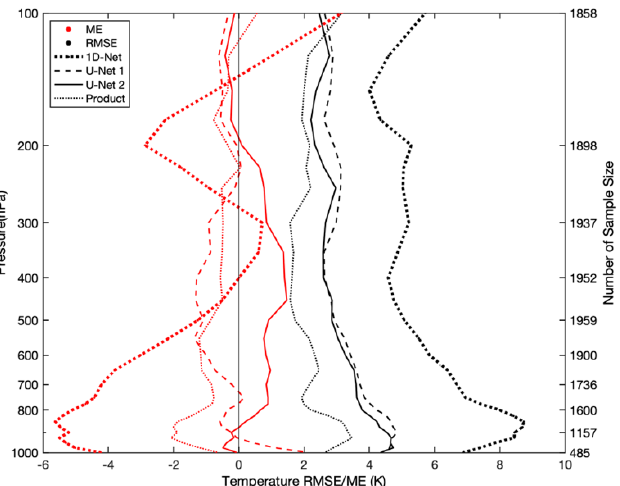
Figure 12. Temperature retrieval error profiles compared with radiosonde under clear FOVs for February 2021. The color and line shape denote the same as Figure 10.